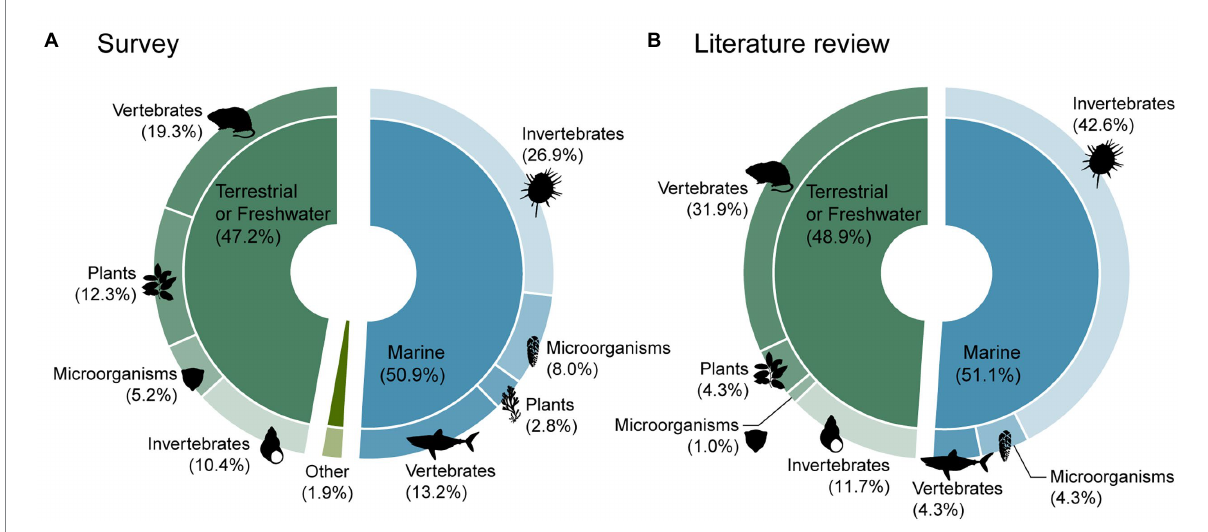
FIGURE 4 Relative proportions of taxonomic groups and habitats studied by (A) survey participants who self-identified as conservation paleobiologists and (B) publications in the literature review. Four survey participants worked on taxa that were not included in the categories provided (e.g., terrestrial fungi). Marine and terrestrial (including freshwater) habitats received similar attention across CPB research, although marine invertebrates and terrestrial vertebrates were disproportionately studied relative to other taxonomic groups. Graphics were obtained from the PhyloPic image library and are attributed to: K. S. Collins, T. J. Cunha, Y. Wong, N. Vitek, H. N. Eyster (CC BY 3.0), D. W. Bapst (modified from Figure 1 of Belanger (2011) PALAIOS; CC BY 3.0), I. Contreras (CC BY 3.0), and T. M. Keesey and Tanetahi (CC BY